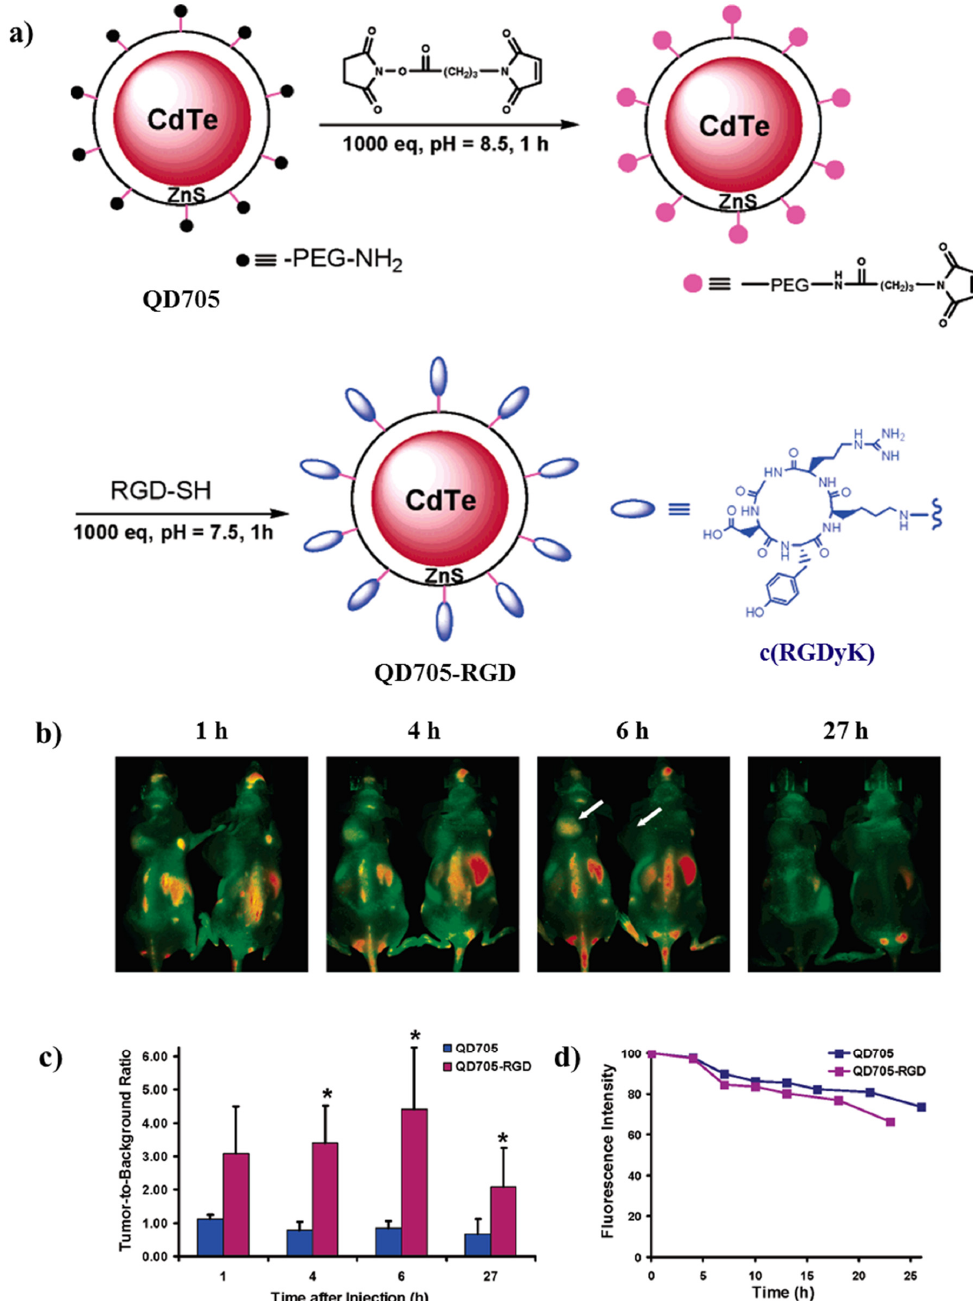
Figure 14. ( a ) Synthetic pathway for the preparation of QD705-RGD. ( b ) In vivo NIR fluorescence imaging of U87MG tumor-bearing mice (left shoulder, pointed by white arrows) injected with 200 pmol of QD705-RGD (left) and QD705 (right), respectively. All images were acquired under the same instrumental conditions. The mice autofluorescence is color coded green while the unmixed QD signal is color coded red. Prominent uptake in the liver, bone marrow, and lymph nodes was also visible. ( c ) Tumor-to-background ratios of mice injected with QD705 or QD705-RGD. The data were represented as mean (standard deviation (SD)). Using one-tailed paired Student’s t-test ( n ) 3),”*” denotes where p < 0.05 as compared to the mice injected with QD705. ( d ) Serum stability of QD705 and QD705-RGD in complete mouse serum over the course of 24 h. Reprinted with permission from [95]; copyright (2006) American Chemical